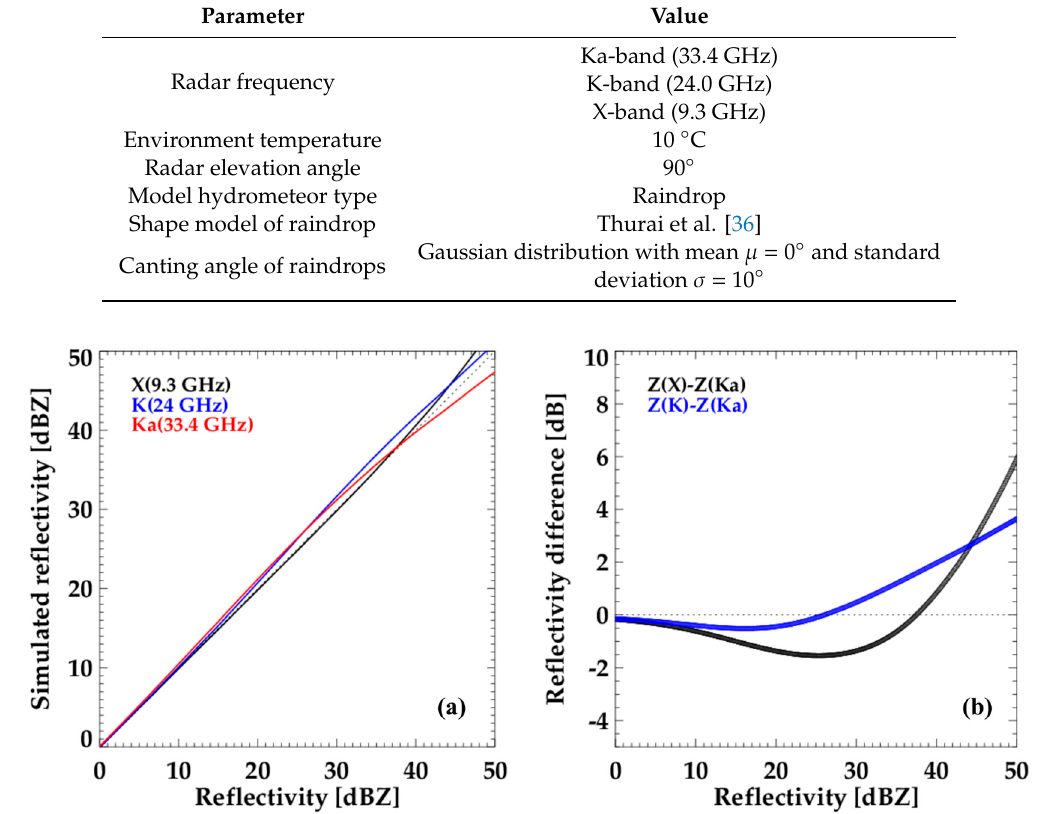
Table 3. Controlled conditions for the T-matrix simulation. Parameter Value Radar frequency Ka-band (33.4 GHz) K-band (24.0 GHz)